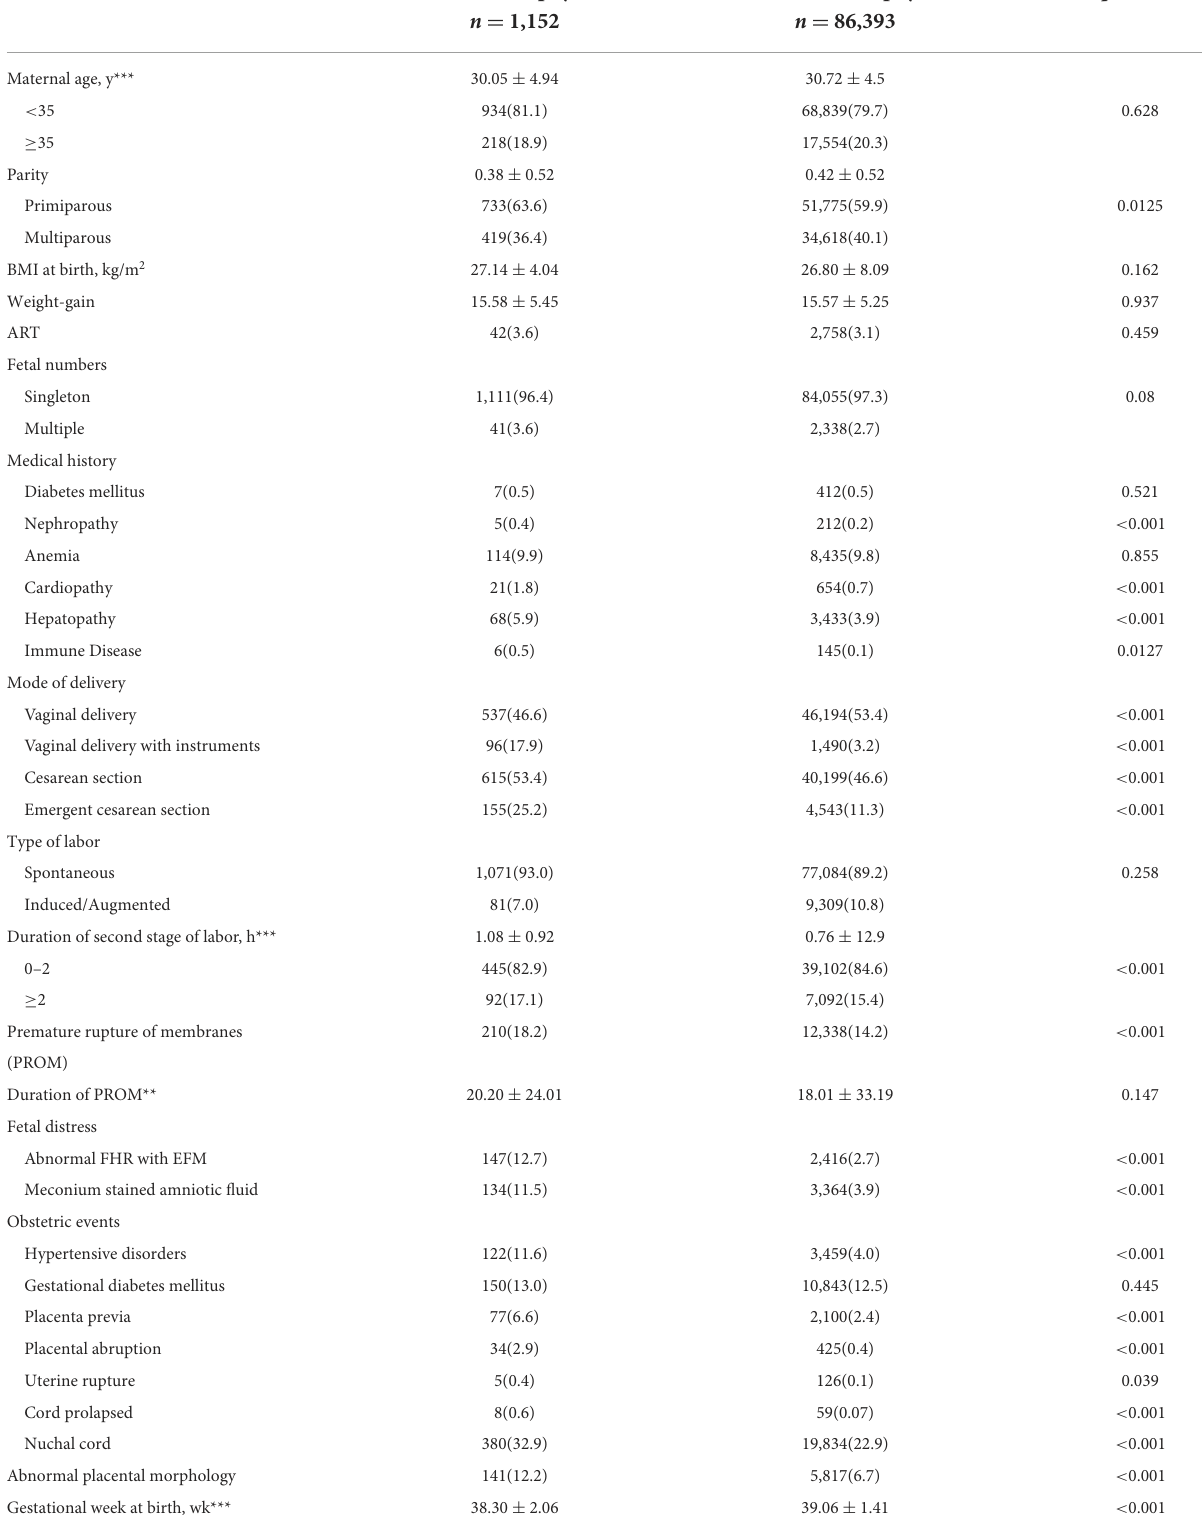
TABLE 2 Maternal characteristics and perinatal events established for neonatal asphyxia [Data was given as mean ± SD or n